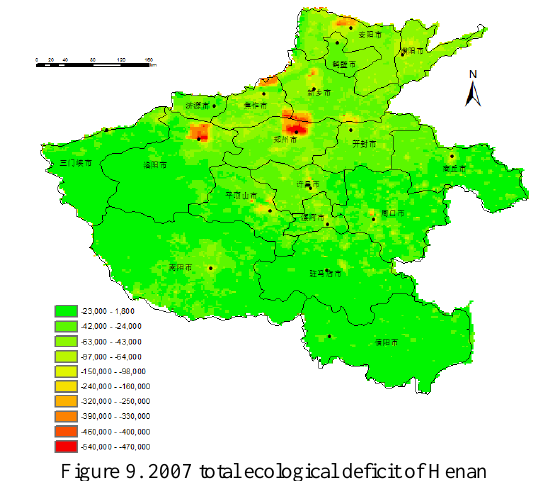
Figure 8. Forecast of Ecological Deficit in Henan Province from